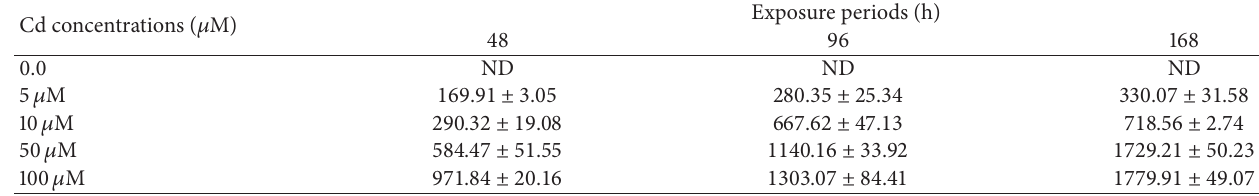
Table 4: Accumulation of Cd ( 𝜇 gg − 1 dw) in B. monnieri at different concentrations and exposure periods. Cd concentrations ( 𝜇 M)